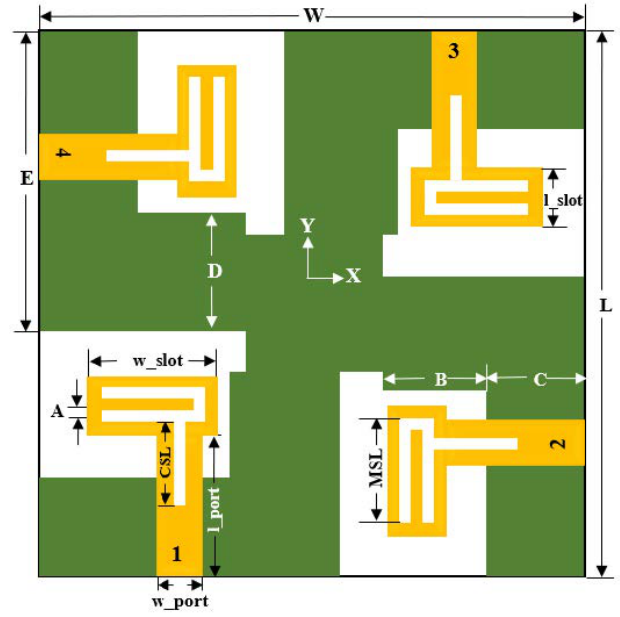
Figure 1. Structure and dimensions of proposed 4 × 4 MIMO antenna.